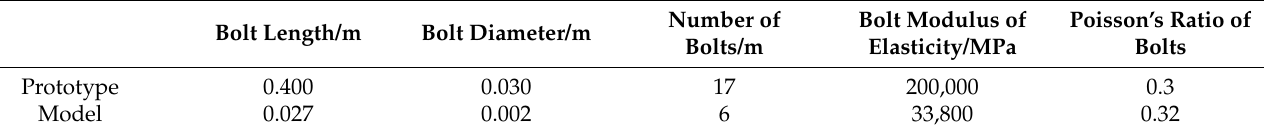
Table 4. Geometric parameters and material properties of the tunnel connection bolts.